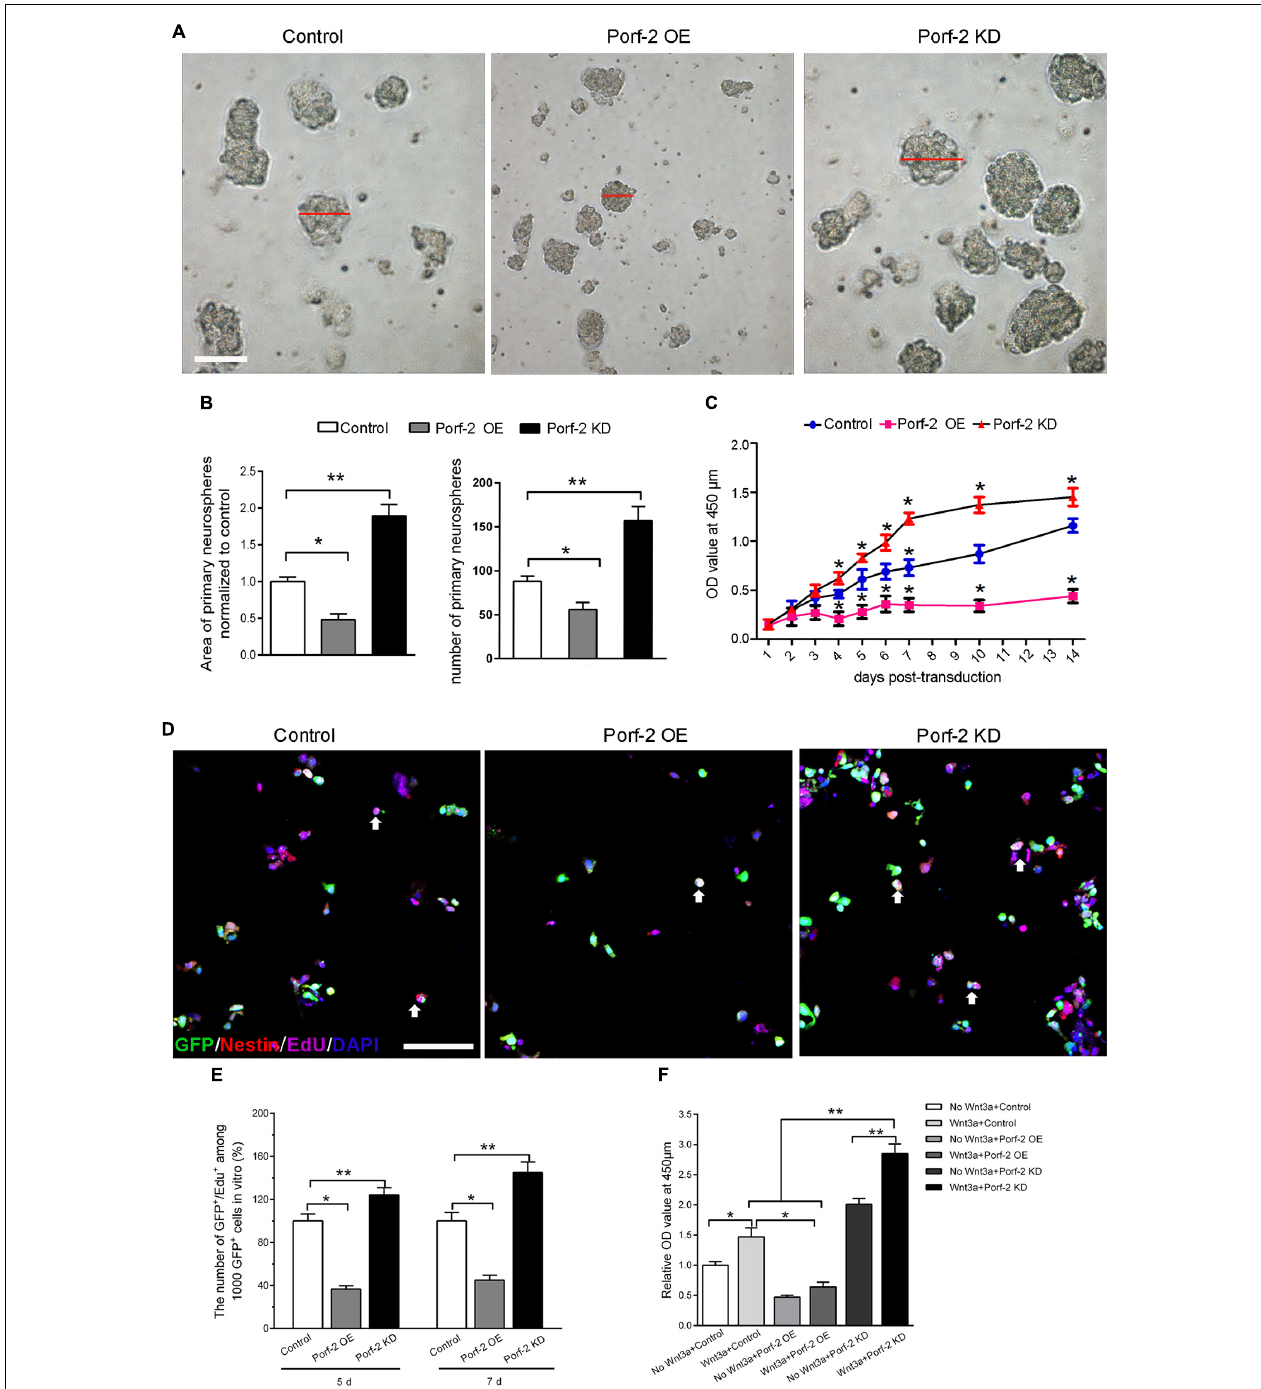
FIGURE 2 | Porf-2 reduces growth/proliferation of hippocampus-derived NSCs. (A) Representative images of NSC neurospheres in Control, Porf-2 KD, and Porf-2 OE groups. The red line indicated the diameter of the neurosphere. Scale bar: 100 µ m. (B) Quantification of the area and the number of neurospheres in each group. The data was normalized to the Control group. Values are expressed as the mean ± SD ( n = 3). ∗ p < 0.05, ∗∗ p < 0.01. (C) CCK-8 assays were performed to analyze the growth/proliferation of NSCs in different groups. Significant changes are shown as ∗ p < 0.05 vs. the control group. (D) Porf-2 knockdown NSCs, Porf-2-overexpression NSCs, and GFP-NSCs were seeded into 96-well culture plates 5, 7 days after transduction. The white arrow indicates the EdU + GFP + neural stem cells. The EdU assay was performed in each group. Scale bar: 100 µ m. (E) The relative proliferation ratios (EdU + GFP + /GFP + ) were calculated and normalized to control group (GFP-NSCs). (F) CCK8 assay showed the effect of Wnt3a protein on Porf-2 knockdown and Porf-2-overexpression-NSCs proliferation. Values are expressed as mean ± SD ( n = 3). ∗ p < 0.05, ∗∗ p < 0.01.